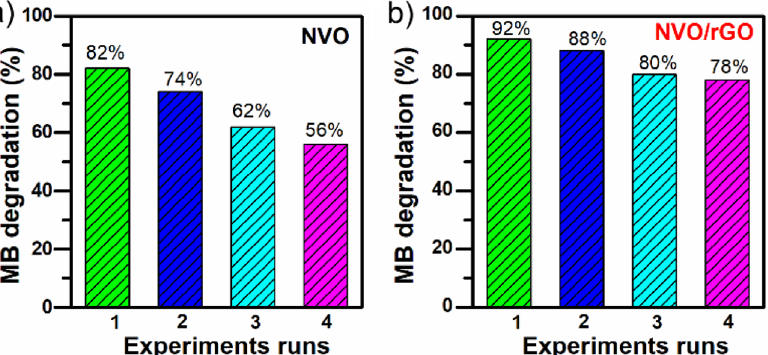
Figure 6. Reusability of the NVO ( a ) and NVO/rGO ( b ) photocatalysts for the degradation of MB.